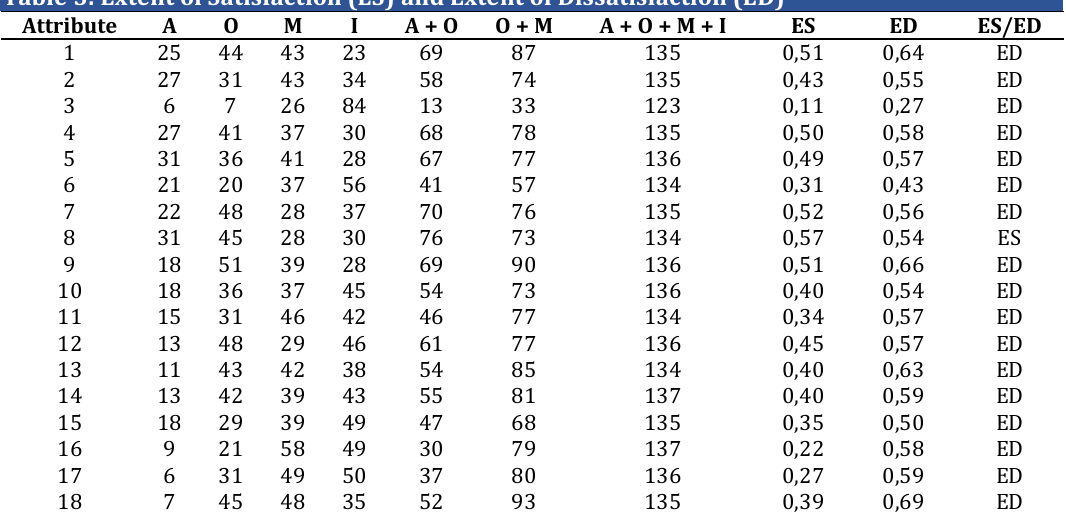
Table 5: Extent of Satisfaction (ES) and Extent of Dissatisfaction (ED)